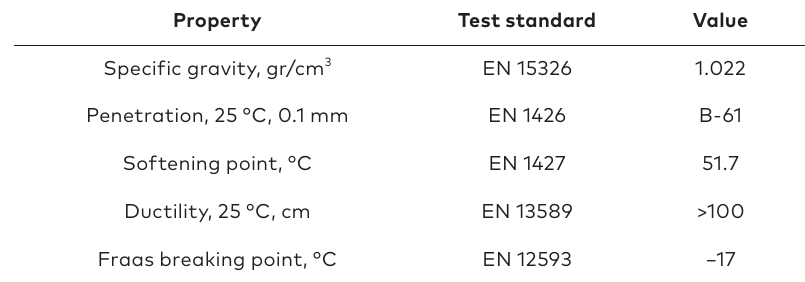
Table 2. Properties of the neat bitumen